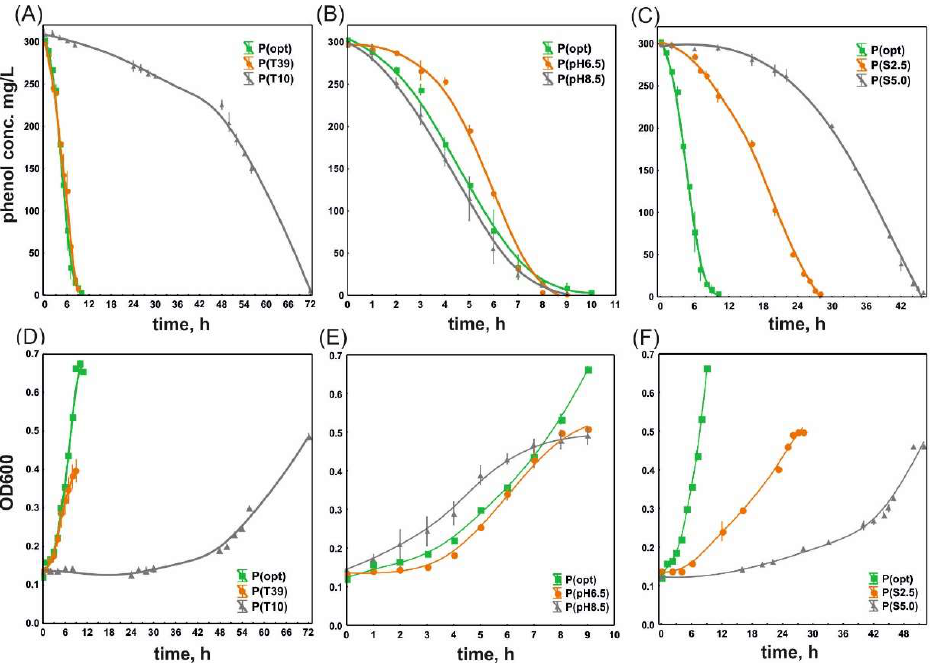
Figure 2. Phenol degradation rates ( A – C ) and the growth curves of S. maltophilia KB2 ( D – F ) under different culture conditions. Abbreviations: P – phenol (300 mg/L); opt – optimal conditions, T – temperature, pH – pH value; S – salinity.